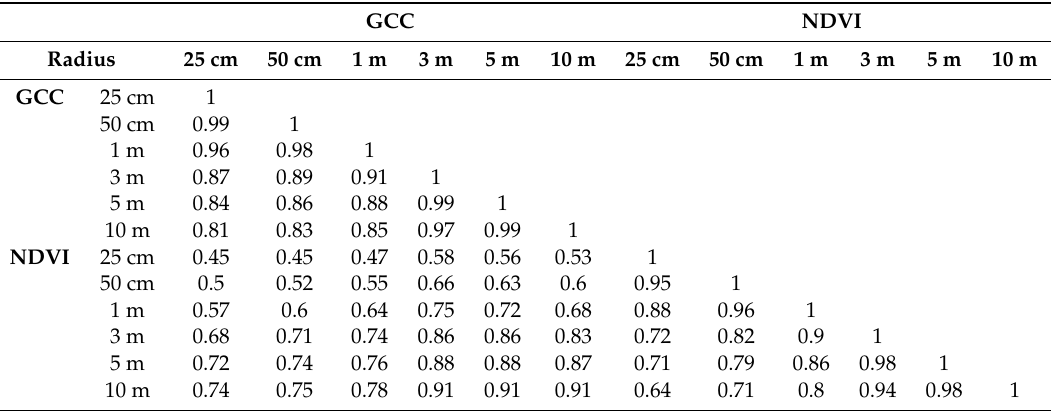
Figure 4. Linear models testing for a relationship between vegetation indices and basal area (BA). Graphs show fitted relationship with 95% confidence intervals and raw point data. Shrub basal area was not predicted well by GCC ( B ; R 2 = 0.29) or NDVI ( D ; R 2 = 0.28). Tree basal area was predicted poorly by GCC ( A ; R 2 = 0.14) and was predicted best by NDVI ( C ; R 2 = 0.52). Table 3. Correlation coe ffi cients between GCC and NDVI at increasing spatial resolution. All paired correlations are reported, but we are primarily interested in the correlation coe ffi cients between GCC and NDVI for each radius. The correlations are assessing the relationship between GCC and NDVI for the mean pixel value of all pixels within a circular plot with the radius indicated. The radius was centered on the field plot